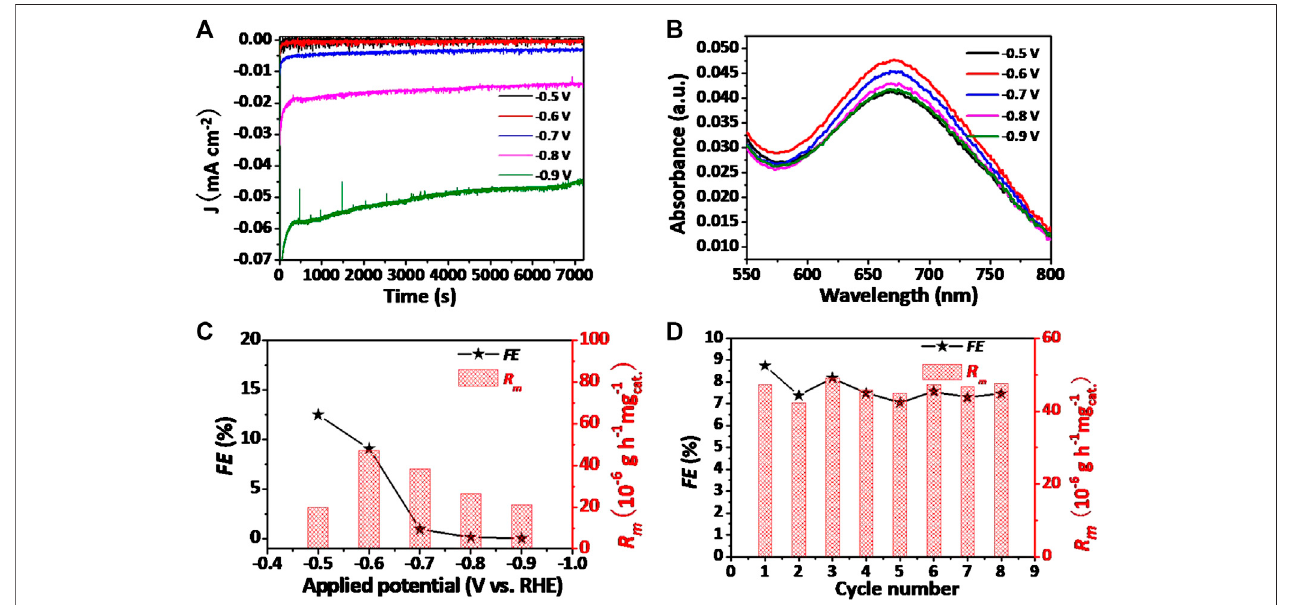
FIGURE 6 | (A) Chronoamperometry curves of V 2 O 3 /CPE at varied potentials. (B) UV-Vis absorption spectra of the solution mixed with indophenol indicator after electrochemical N 2 fi xation at a series of potentials for 2 h. (C) Average NH 3 yields and FEs of V 2 O 3 /CPE at different potentials. (D) Cycling test of V 2 O 3 /CPE during N 2 fi xation at − 0.6